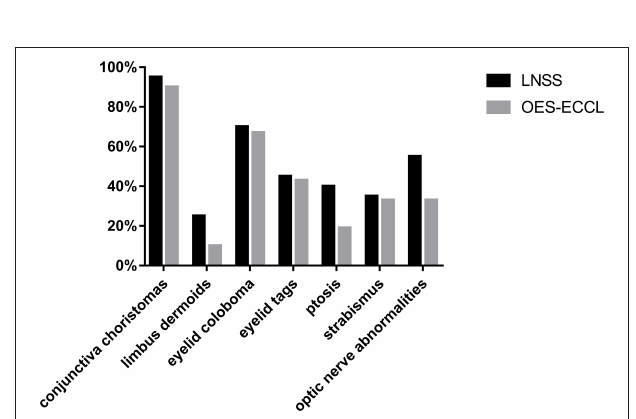
FIGURE 3 | The prevalence of main ocular manifestations in patients with LNSS and